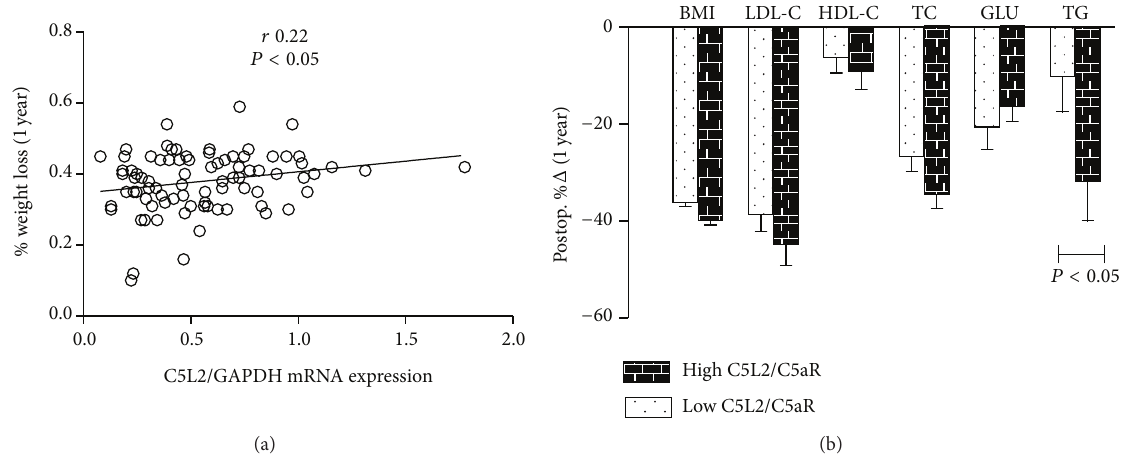
Figure 4: Metabolic profile after surgery. mRNA was extracted from liver biopsies and reverse-transcribed to cDNA and gene expression was evaluated by RT-PCR with the indicated primers with all results expressed relative to GAPDH using the ΔΔ Ct method as described in detail in Section 2. (a) Linear correlation plot of liver C5L2 mRNA expression at time of surgery versus % weight loss 12 months after surgery, analyzed byPearsoncorrelationtest.(b)Percentagechangesofmetabolicprofilebeforeandafterbariatricsurgeryandcategoricalcomparisonsbetween the high and low C5L2/C5aR mRNA ratio subgroups, analyzed by Fisher exact test. BMI: body mass index; GLU: fasting glucose; HDL-C: high density lipoprotein-cholesterol; LDL-C: low density lipoprotein-cholesterol; TG: triglyceride; TC: total cholesterol.